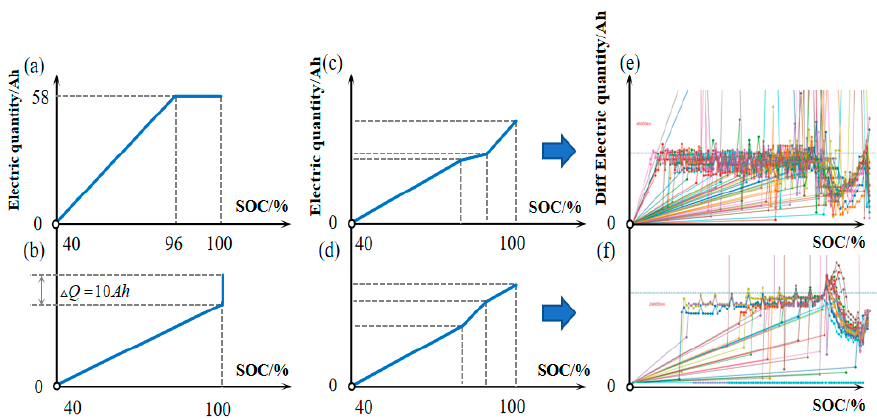
Figure 3. High SOC correction strategy ( a – f